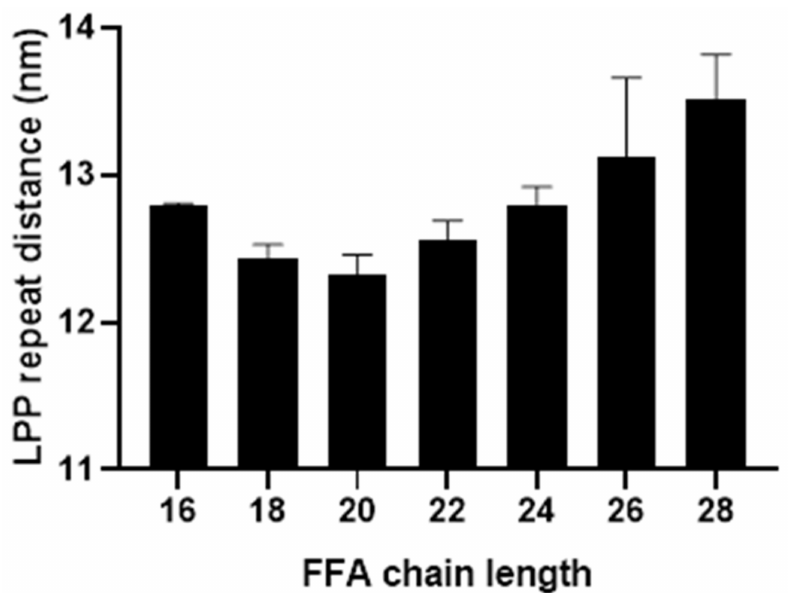
Figure 1. The average repeat distance of the long periodicity phase (LPP) in the simple model with free fatty acid (FFA) C16–28. Between C20 and 28, the LPP repeat distance increases as the chain length increases, while at C16–18 the LPP repeat distance increases as the FFA chain length decreased. The LPP repeat distances for the models containing C16, C18, C20, C22, C24, C26, and C28 were 12.8 ± 0.02, 12.4 ± 0.1, 12.3 ± 0.1, 12.6 ± 0.1, 12.8 ± 0.1, and 13.1 ± 0.5, respectively. Error is calculated as the standard deviation between repeat